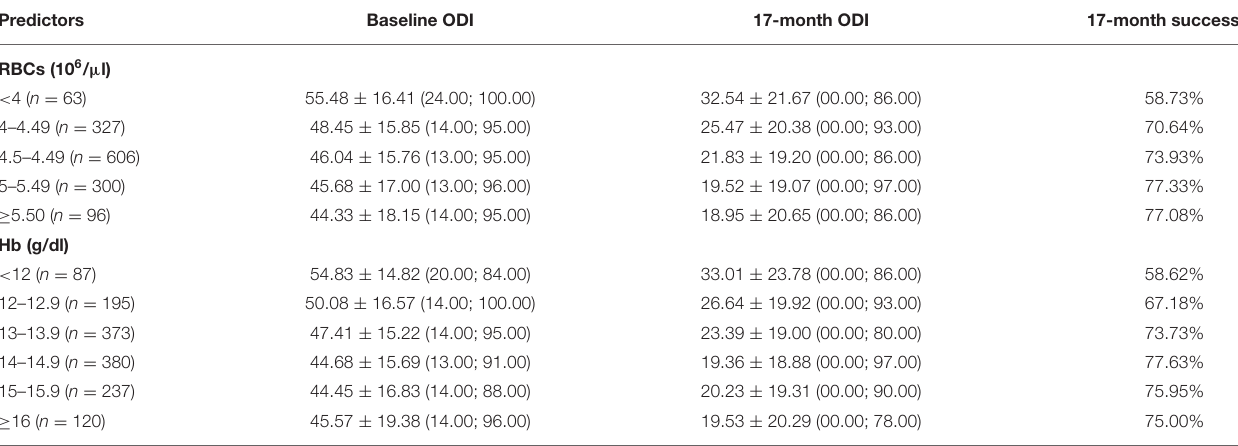
TABLE 5 | Recovery from disability trends using scaled erythrocytes and